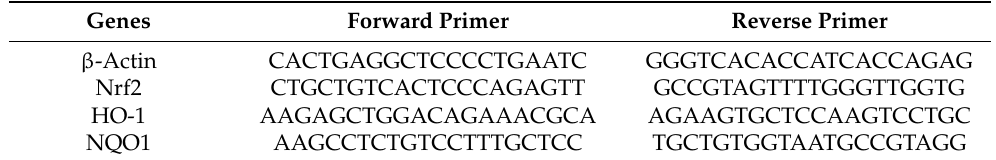
Table 1. Sequences of primers for quantitative real-time PCR.